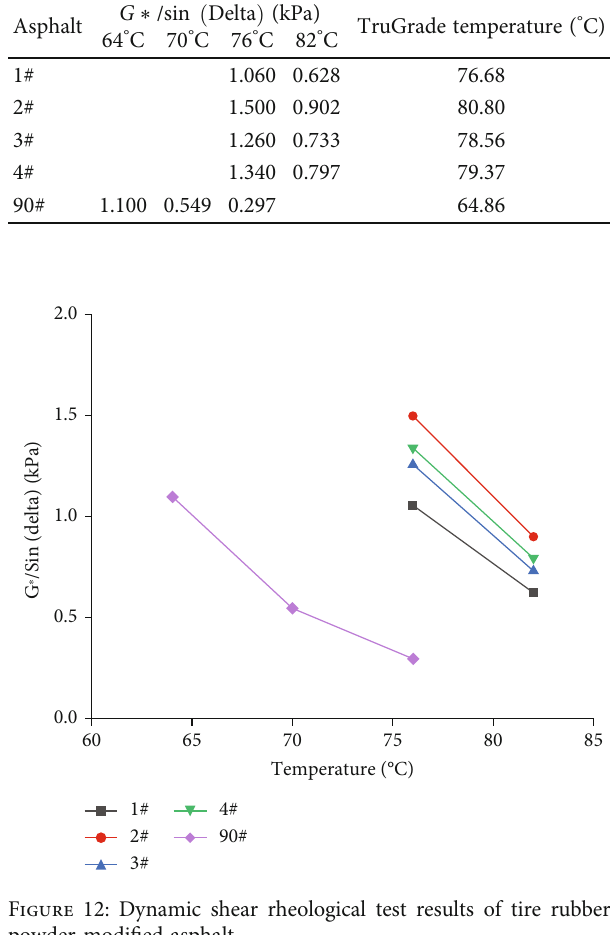
Figure 12: Dynamic shear rheological test results of tire rubber powder-modi fi ed